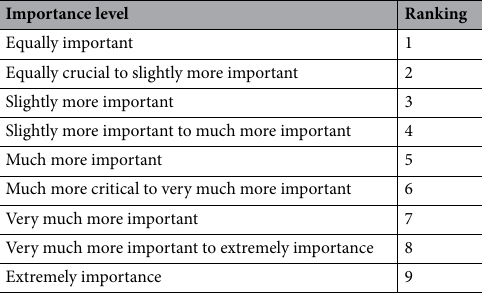
Table 3. Pairwise comparison point-based rating scale of ANP.